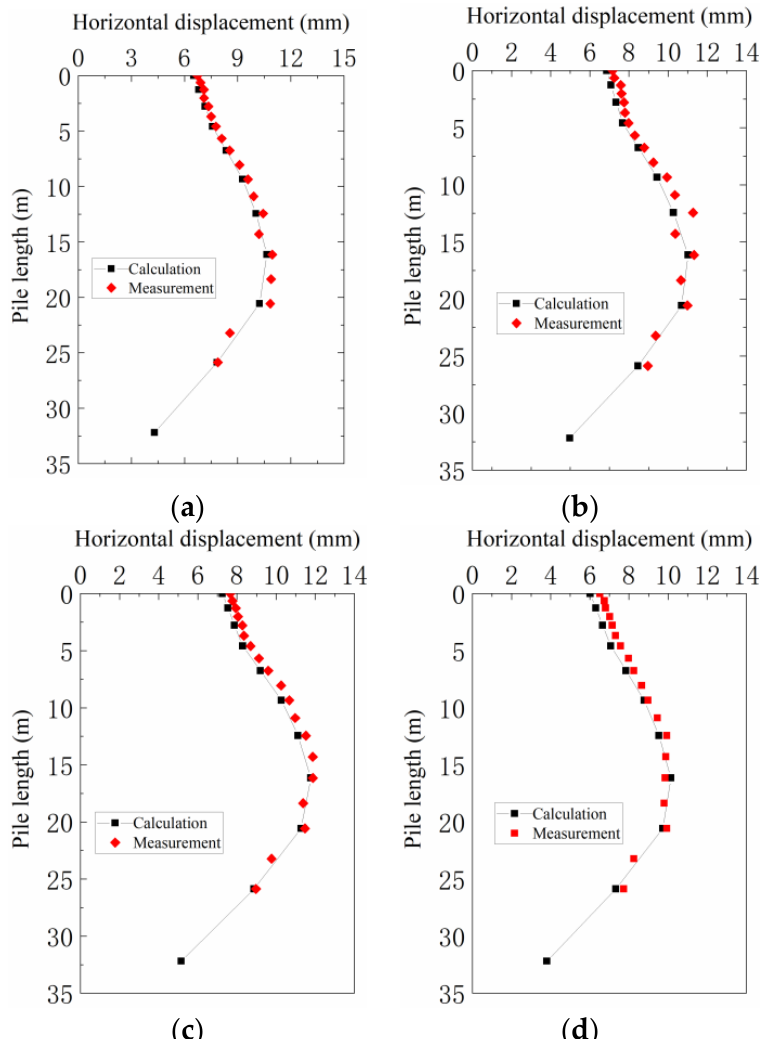
Figure 16. Comparison of measured data and calculation results when excavating to the bottom of the foundation pit. ( a ) Point A; ( b ) Point B; ( c ) Point C; ( d ) Point D.